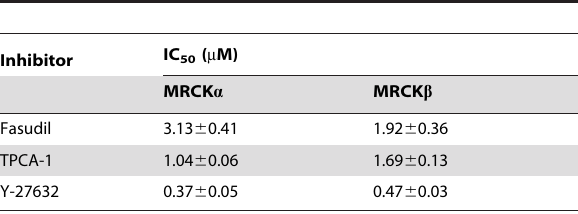
Table 2. IC 50 values obtained for Fasudil, TPCA-1 and Y-27632 in vitro